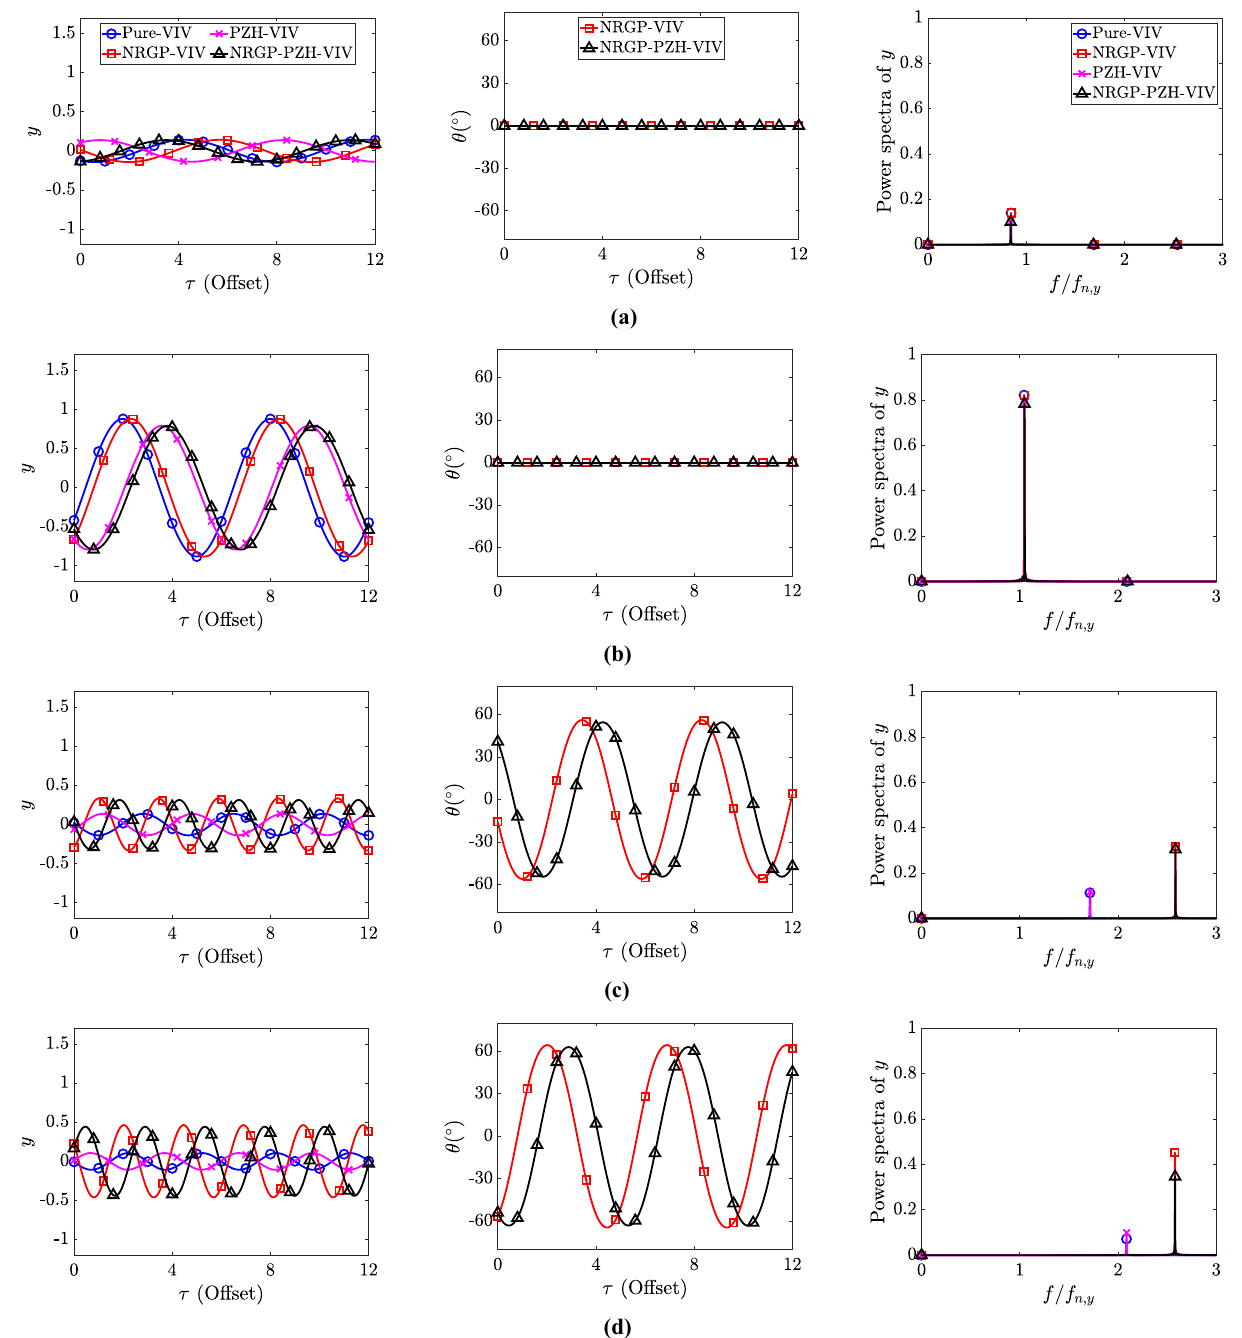
Figure 4. Response amplitude of the cylinder y (left) and angular rotation of the pendulum θ( ◦ ) (middle) and the power spectrum of the amplitude response y (right) for various reduced velocity U r : ( a ) 4, ( b ) 6, ( c ) 12, and ( d ) 14. Note that the X-axis in the time history plots has been offset for Fig. 5c. It can be observed that the non-dimensionalization collapses the response frequency for various ω r along f / f n , p = 2 . As expected, for ω r = 0.5 , the f / f n , p = 2 is equivalent to the VIV synchronization region from U r = 4.5 − 8 , and the parametric synchronization does not happen for U r ≥ 8.5 . For the other cases of ω r = 1 , 1.3 and 1.5, the parametric synchronization occurs at U r = 9 , 11 and 12.5, respectively. This corroborated the observations of the response amplitudes of the cylinder and the pendulum. In the case of ω r = 1 , the drop in the cylinder and pendulum oscillation amplitudes can be associated with the deviation of f / f n , p at U r = 17 to 20. The piezoelectric characteristics for ω r ∈ [ 0.5, 1, 1.3, 1.5 ] and PZH-VIV are presented in Fig. 6. The variation of the root-mean-square of the dimensionless electric tension with the reduced velocity is depicted in Fig. 6a. In the case of PZH-VIV model, the peak v y ,rms is 0.01 at U r = 5.5 . On attaching the pendulum the electric tension increases in the de-synchronized region, which is more prominent with higher values of ω r . The effect of the